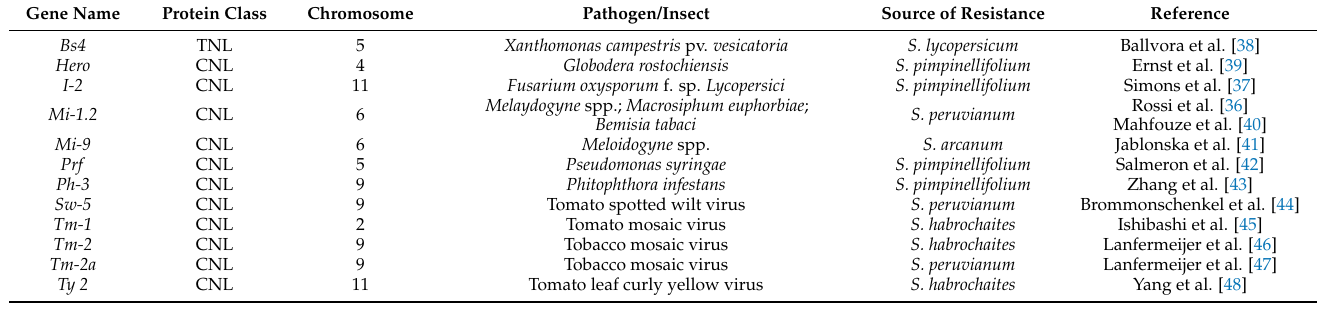
Table 1. List of cloned NB-LRR resistance genes in tomato and its wild relatives. Gene name, protein class, chromosome number and source of resistance for each R-gene were reported.